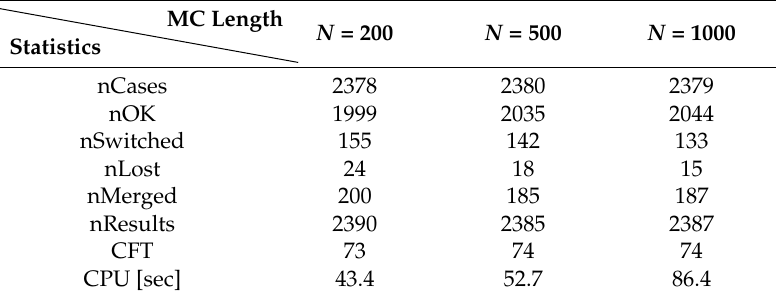
Table 3. Statistics for different MC lengths.